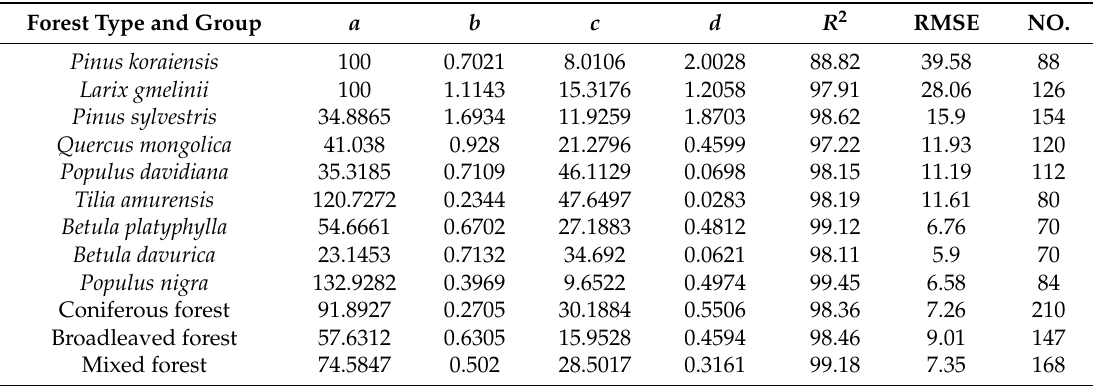
Table 6. The four regression coefficients for Equation (9) for the nine forest types and three forest type